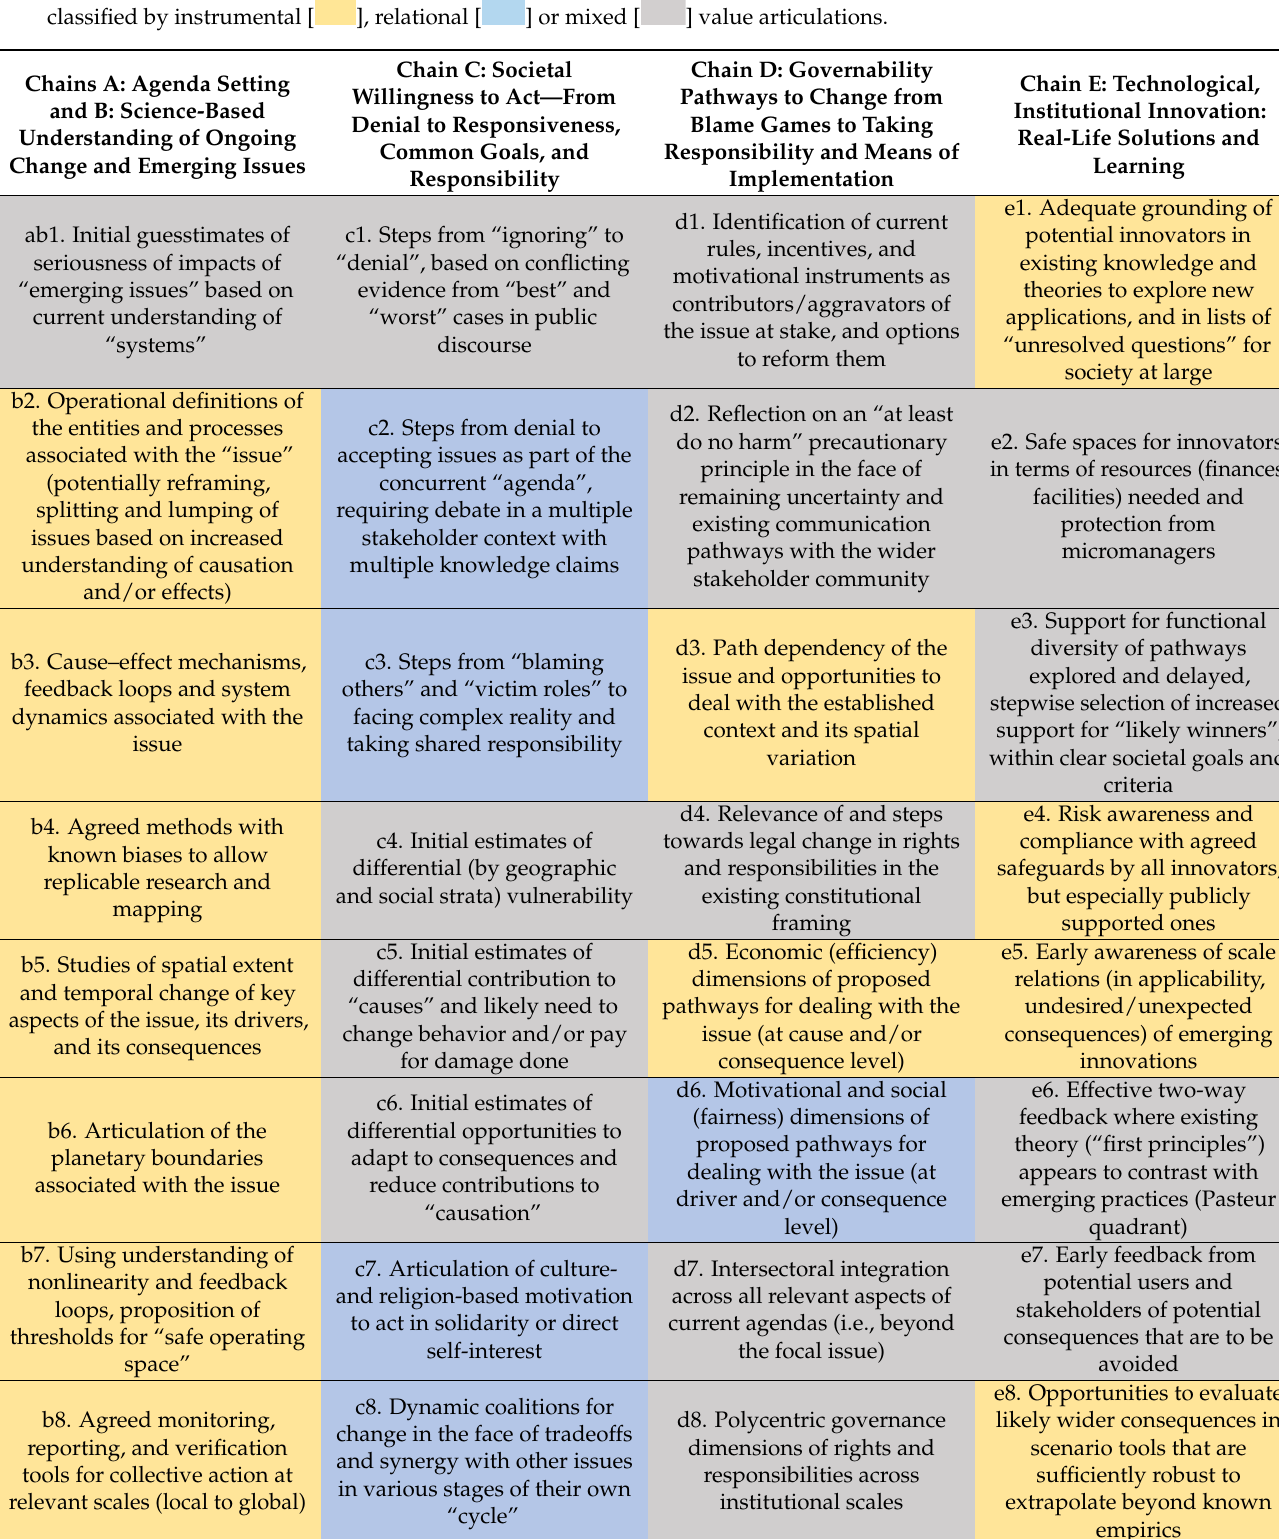
Table 2. Progress markers (from 1 to 10) for four interrelated knowledge-to-action chains in the issue (decisions) cycle